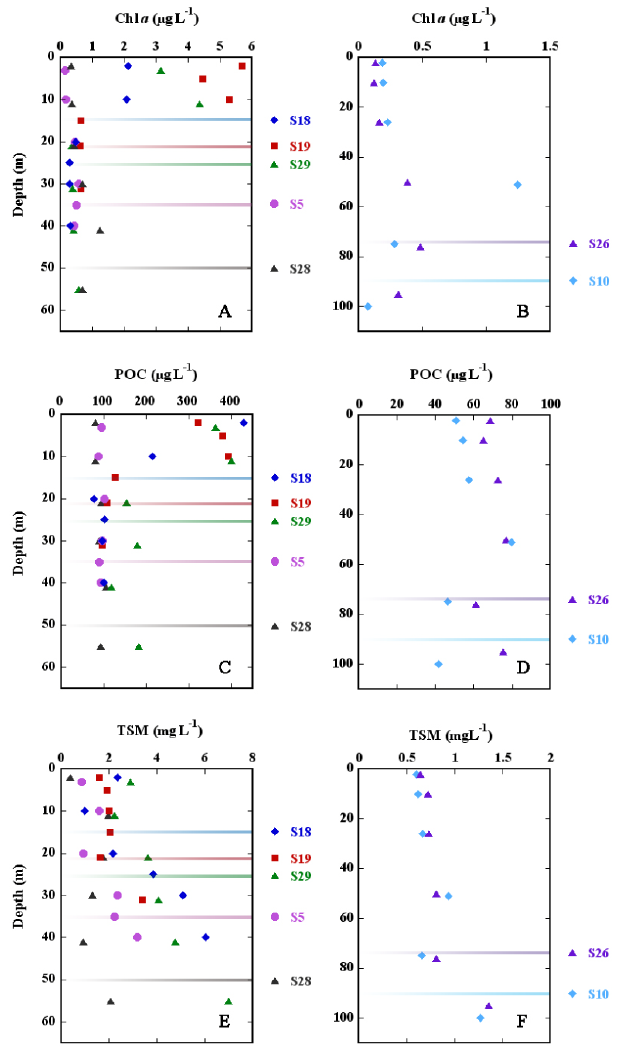
Fig. 3. Distributions of vertical Chl a ( A and B ), POC concentra- tions ( C and D ) and total suspended matter (TSM) concentrations ( E and F ) in the inner shelf (S18, S19, S29, S5, and S28) and the outer shelf (S10 and S26) of the East China Sea. The different color lines indicate the depths of the euphotic zone at stations (S18, S19, S29, S5, S28, S26 and